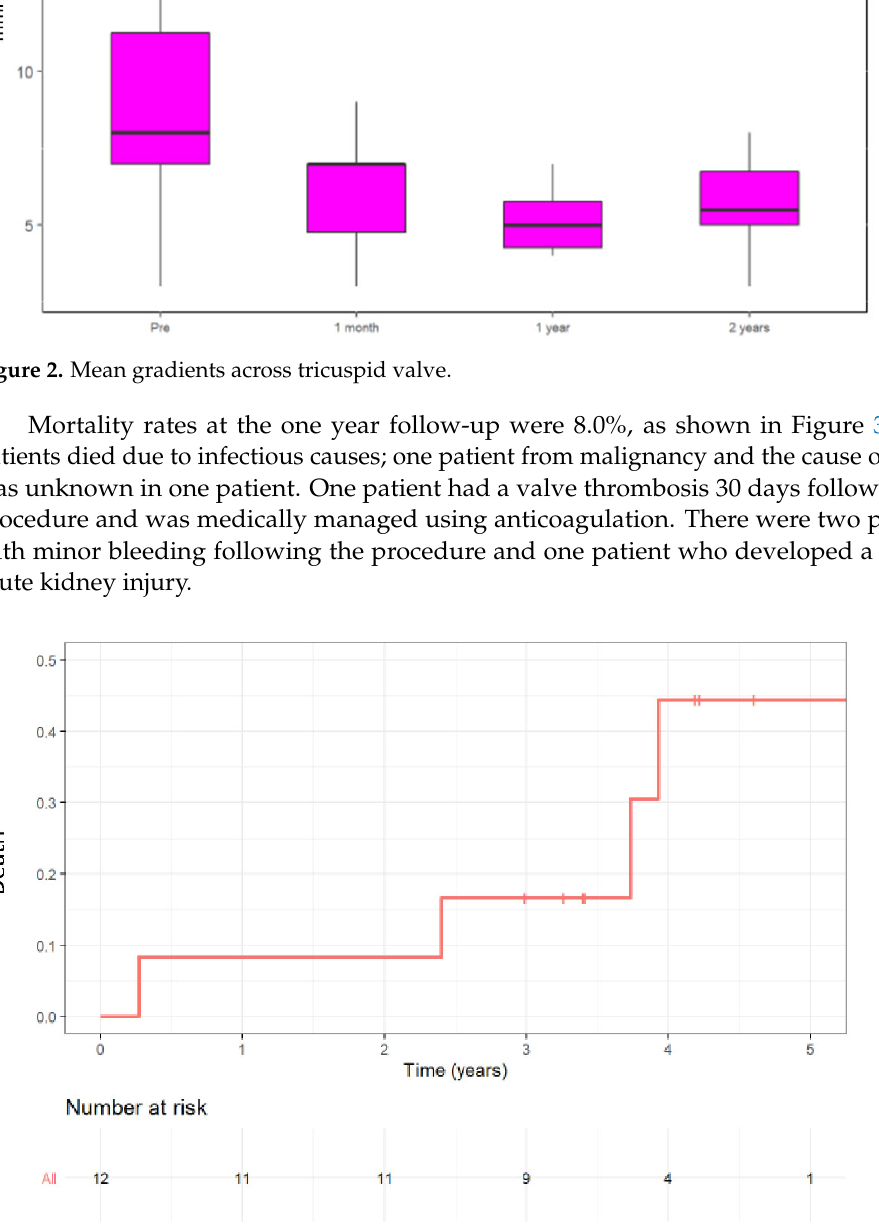
Figure 4. NYHA functional status at baseline and one year follow ‐ up.